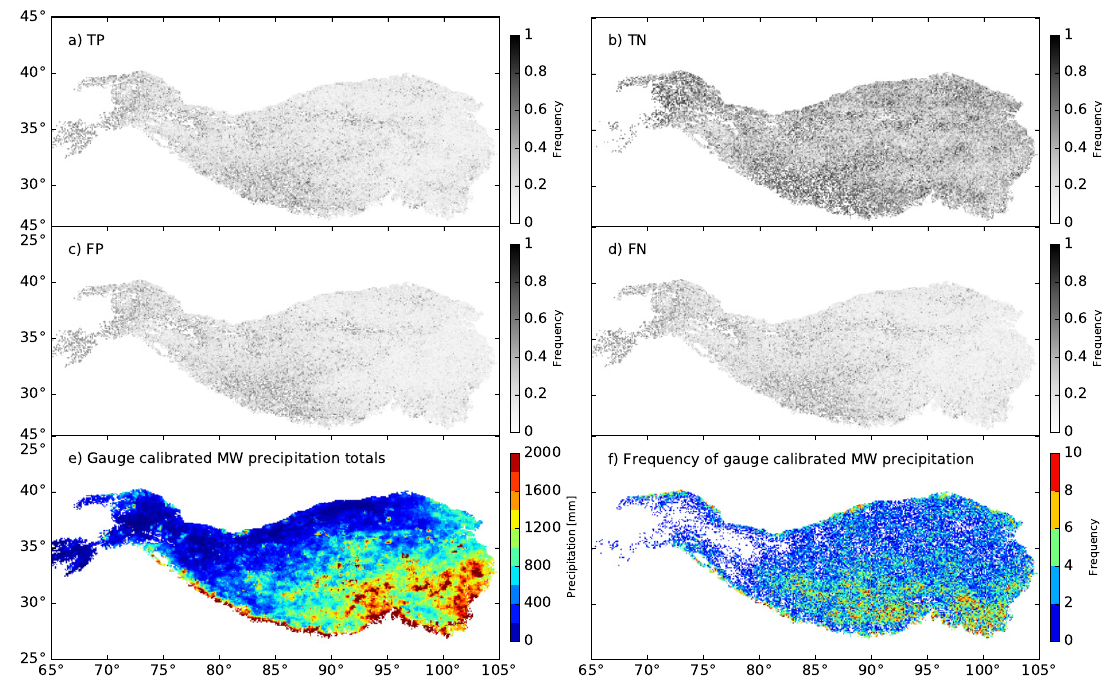
Figure 10. Distribution of mean validation measures over the Tibetan Plateau (TiP) for 2017 ( a – d ) with the precipitation totals ( e ) and frequency of gauge calibrated MW precipitation for 2017 ( f